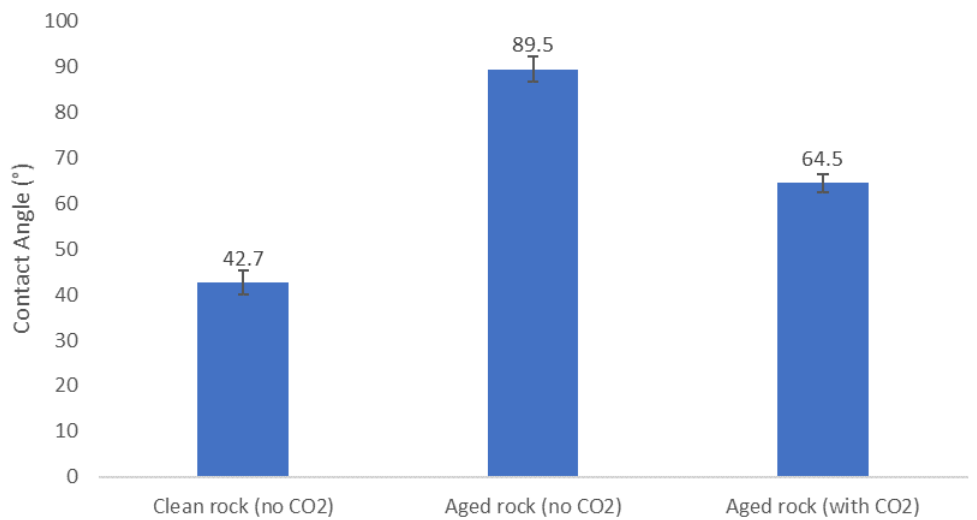
Figure 6. Equilibrium contact angles between Pre-salt crude oil and formation brine on clean and 15 day aged coquinas. The test with CO 2 considers oil and brine saturated with CO 2 . Experiment conditions: 60 °C and 6.895 MPa. The reported value is the mean of triplicate measurements, and the error bars represent the standard error of the mean.